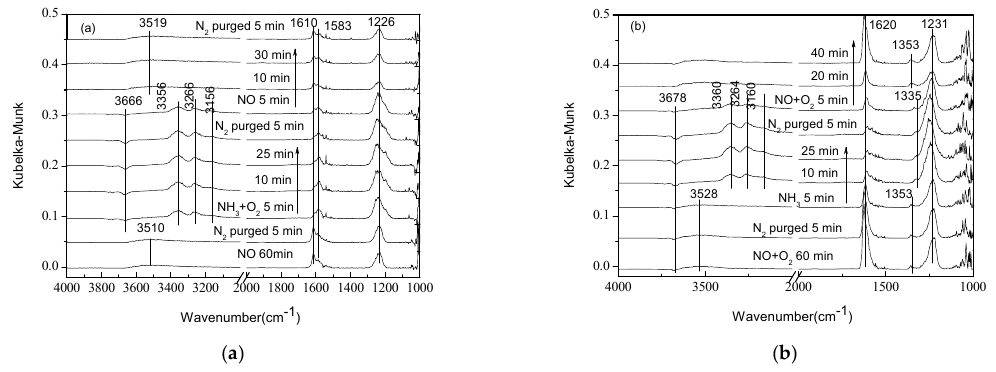
Figure 5. In situ DRIFTS spectra of the transient reactions at 250 °C between ( a ) NO and pre-adsorbed NH 3 + O 2 and ( b ) NH 3 , and pre-adsorbed NO + O 2 species over 1 wt. % V 2 O 5 -0.2CeO 2 /TiO 2 -ZrO 2 catalysts recorded as a function of time.